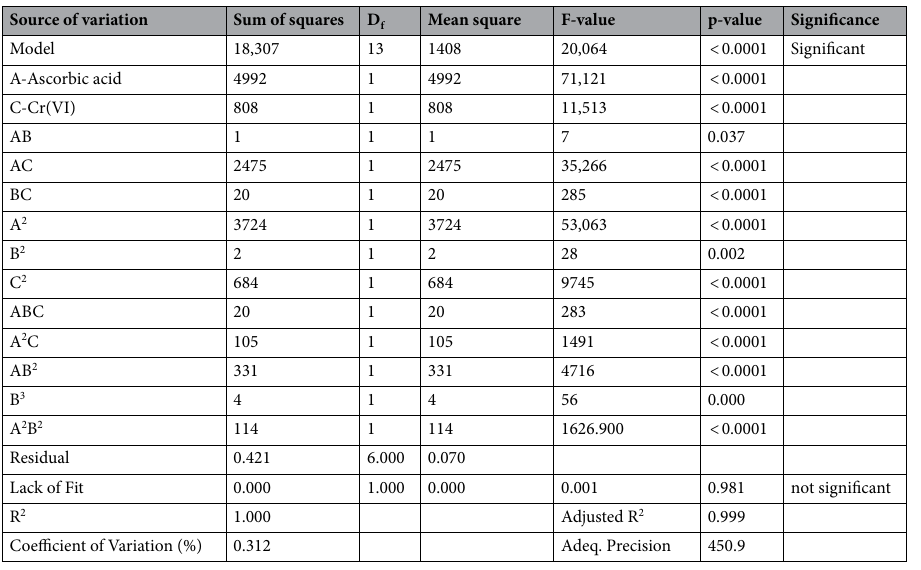
Table 3. The analysis of variance (ANOVA) of the reduced quartic model representing the reduction of Cr(VI) using ascorbic